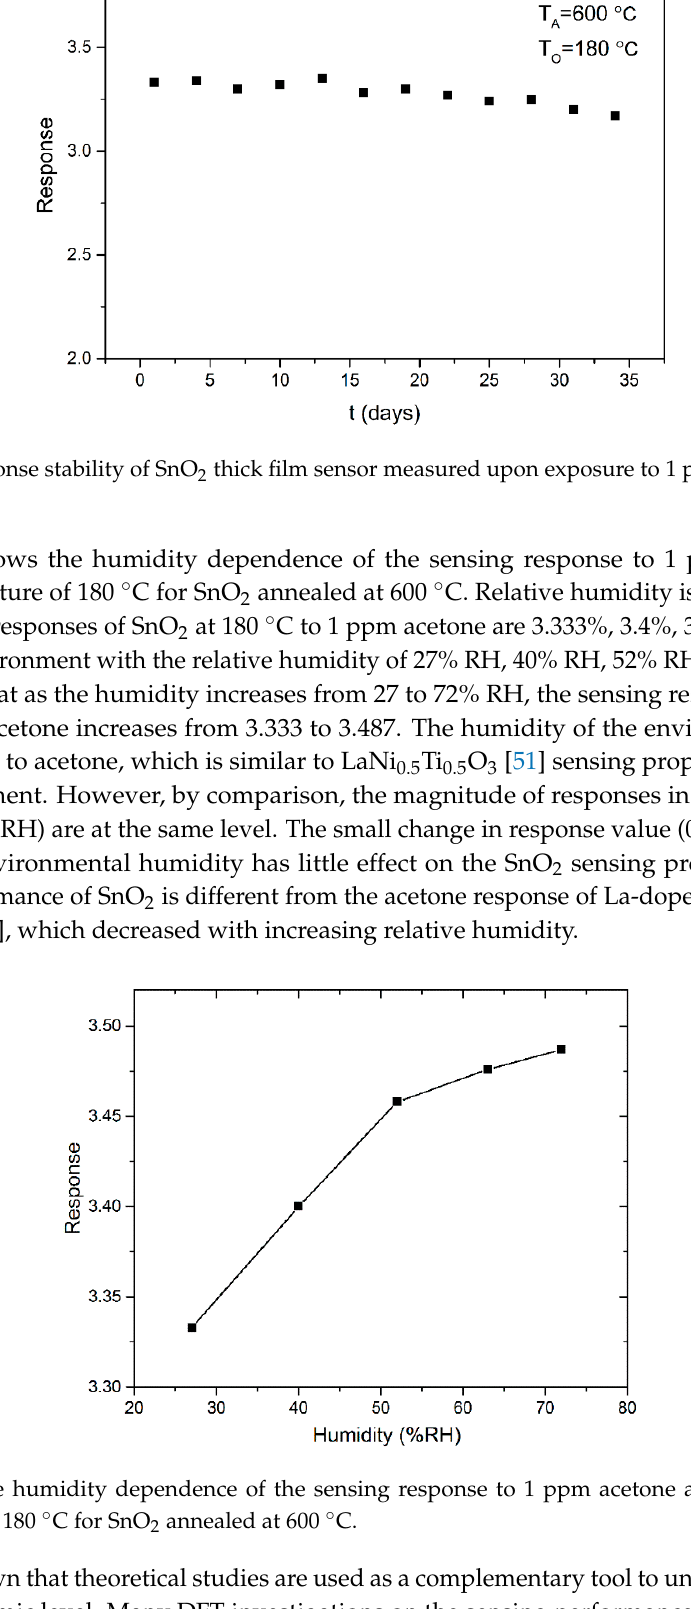
Figure 8. The response of SnO 2 thick film to different gases with a concentration of 1 ppm at 180 °C.